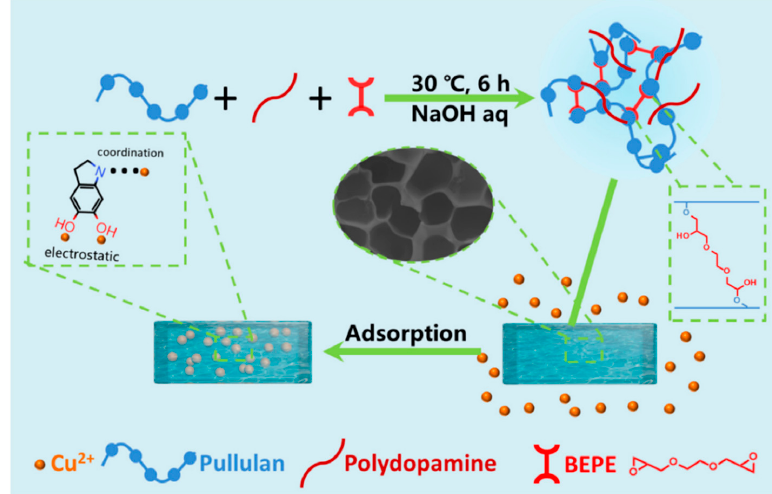
Figure 13. Schematic representation showcasing electrostatic and coordination interaction between pullulan/polydopamine hydrogel and heavy metals. (Reprinted from Ref. [167], Copyright (2022), with permission from Elsevier).